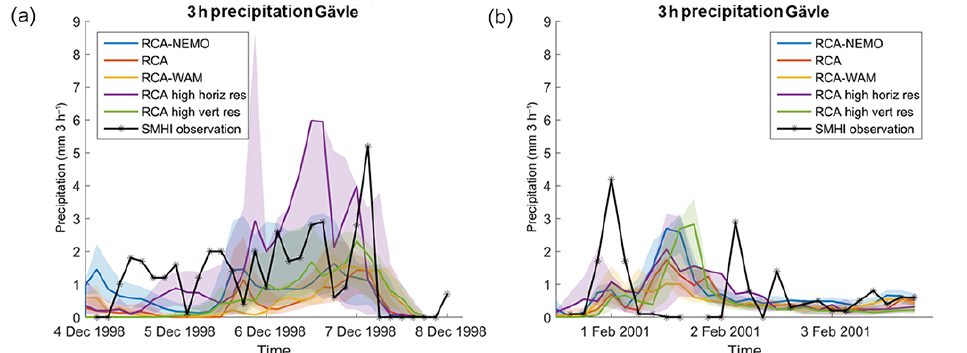
Figure 11. Time series of the precipitation measurements of the SMHI station in Gävle in comparison with the model results for this location. The solid line shows the model simulation at the closest grid point to the measurement site and the shaded area indicates the variation of this result according to the directly neighbouring grid